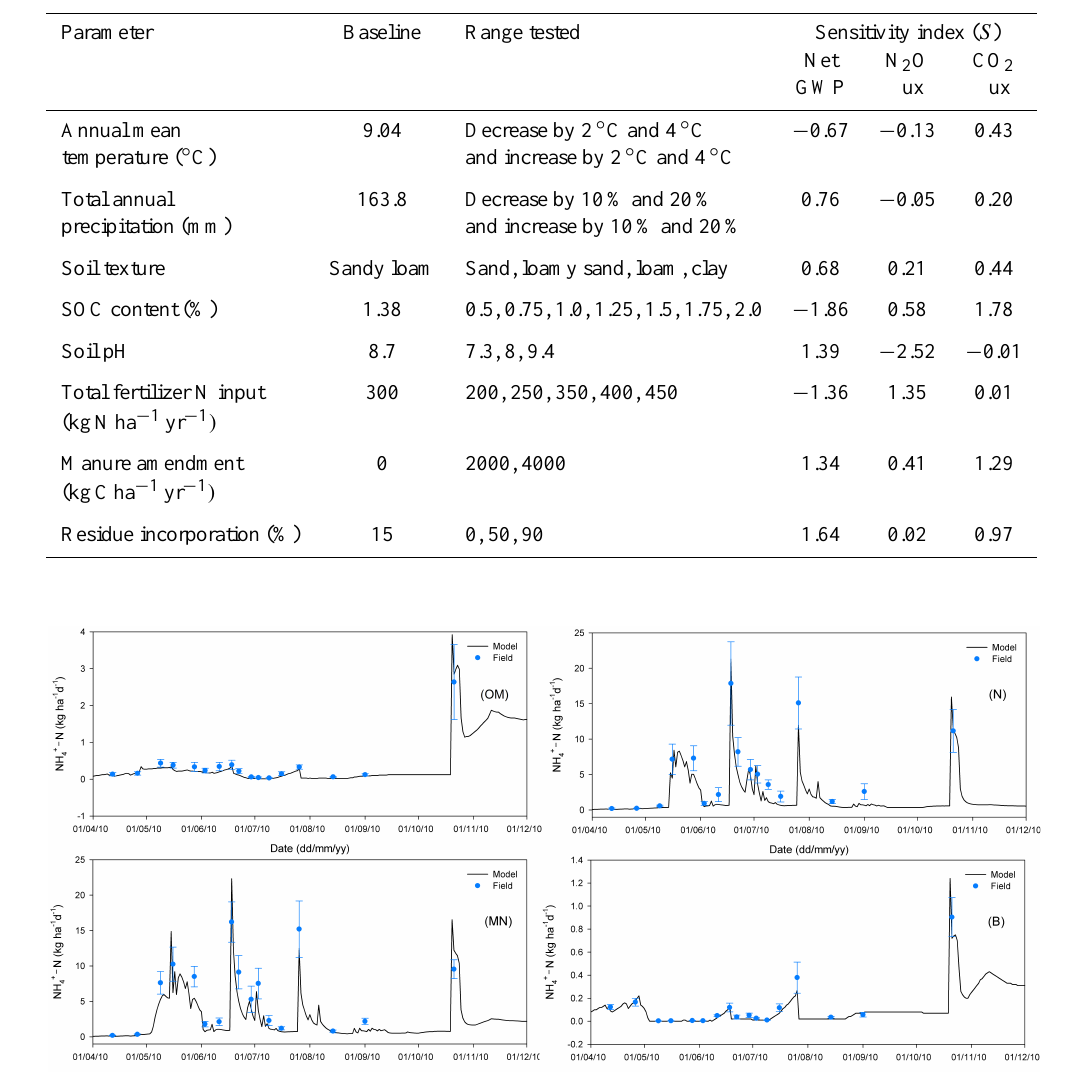
Fig. 6. Comparison of observed and modeled ammonium nitrogen (NH +